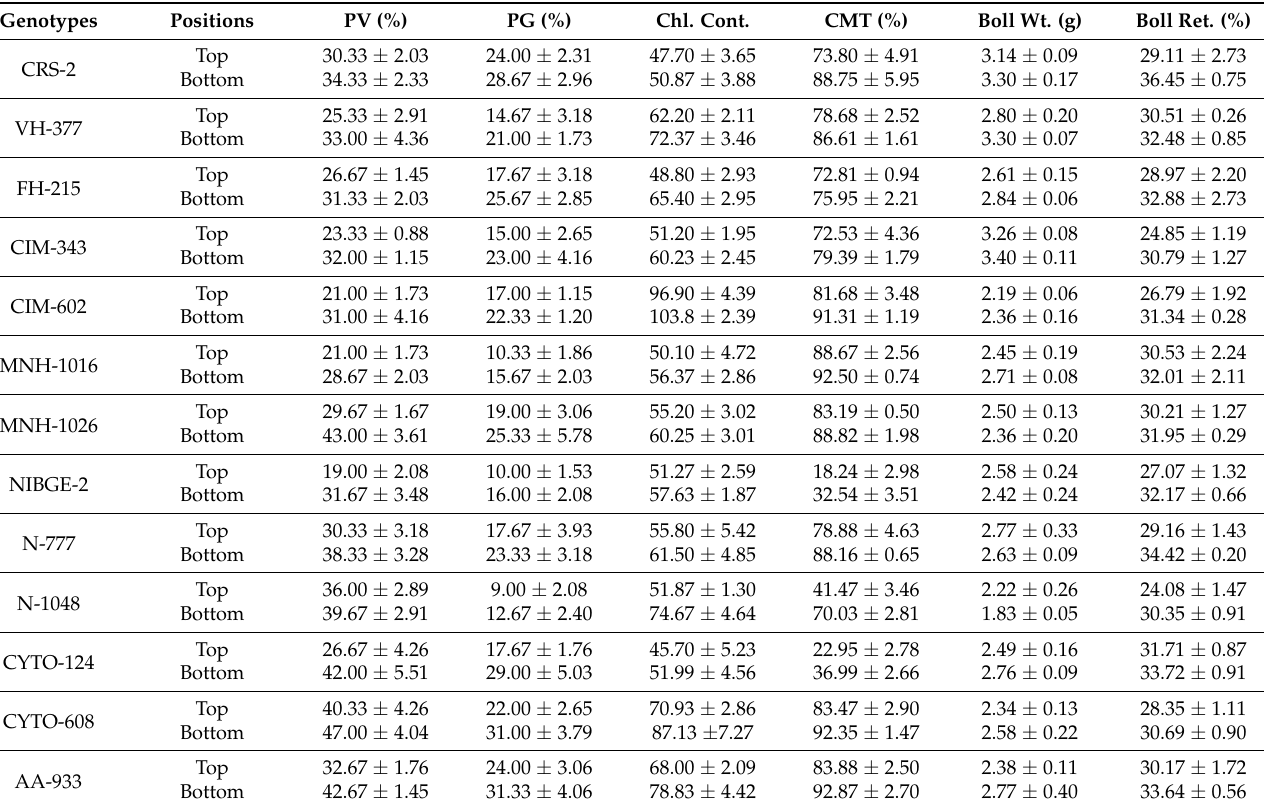
Table 4. Mean values with standard errors for six measures of heat tolerance in the top and bottom positions of 13 cotton genotypes grown in 2019 in Faisalabad,